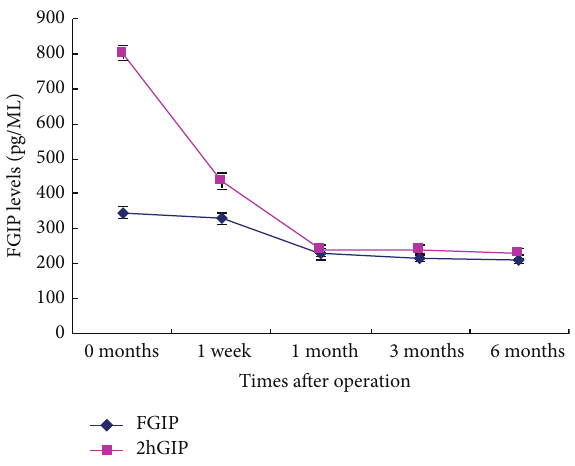
Figure 2: FGIP levels before and after the